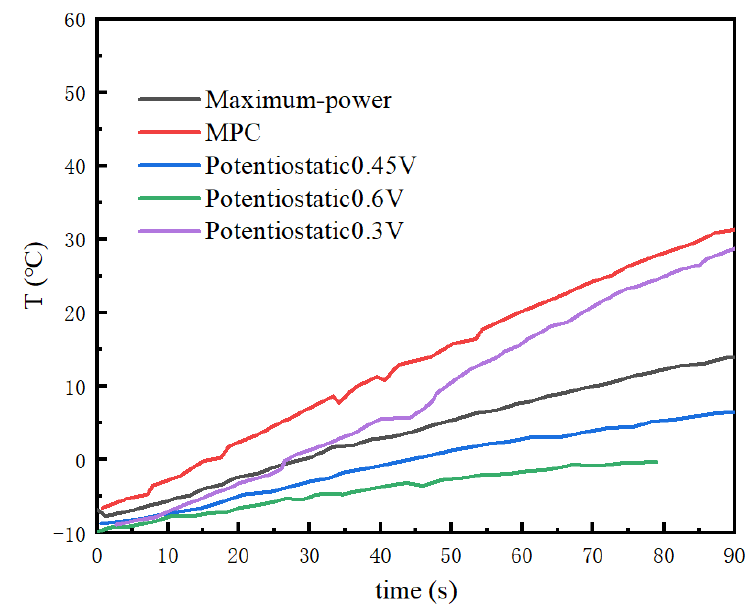
Figure 8. Temperature variation of the stack at − 10 °C in different startup modes.